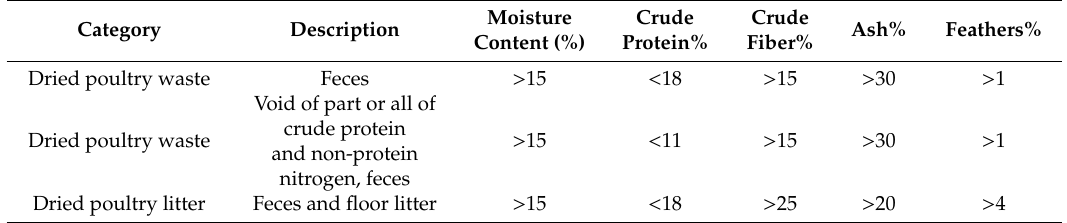
Table 1. Characteristics of processed poultry waste-based animal feeds (FDA,